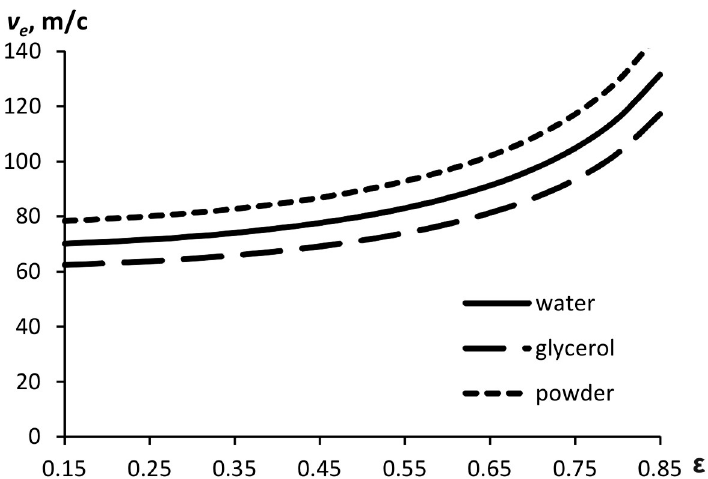
Figure 3. Outflow velocity as a function of compression ratio for substances with different densities ( P = 2.5 MPa).